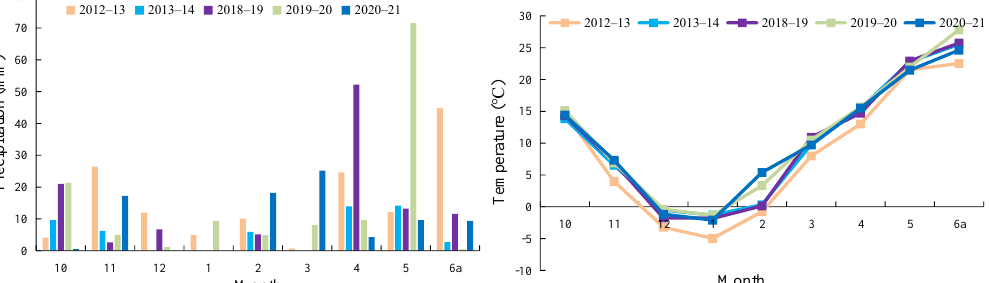
Figure 1. Monthly rainfall and monthly average temperature in each growing season. 6a stands for the period from 1 June to 10 June. Winter wheat is usually harvested around 10 June each year in the experiment location.